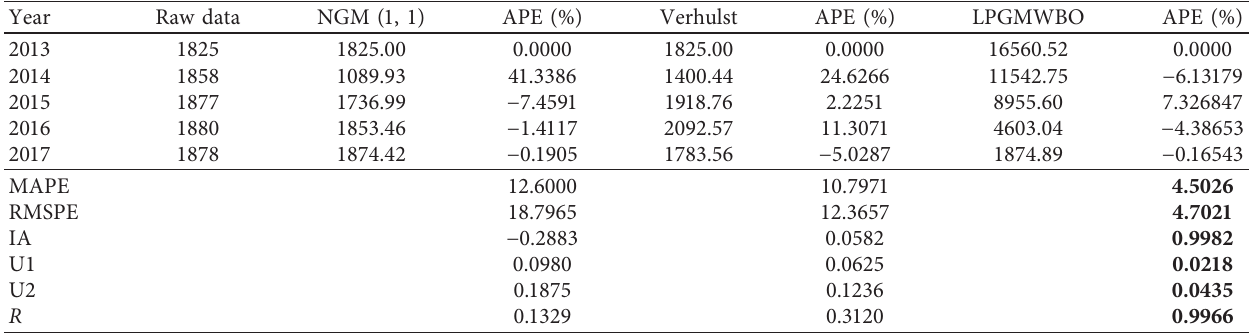
Table 6: Fitting metrics of models for validation of Beijing data.